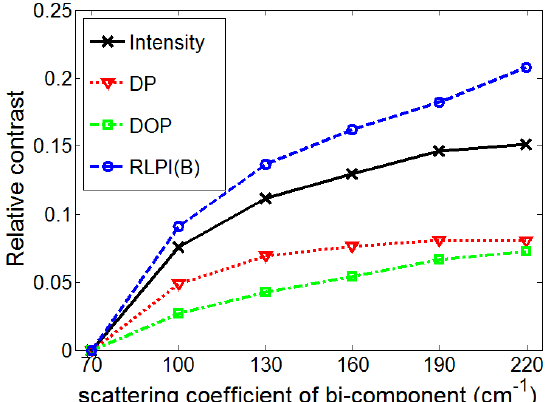
Fig. 5. Monte Carlo simulated relative contrasts of four ima- ging methods: intensity, DP, DOP, RLPI parameter B, at di®erent concentrations for a scattering model with two com- ponents of spherical scatterers. The diameters of small and large spherical scatterer are 0.7 (cid:5) m and 7 (cid:5) m to simulate the nuclei and mitochondria,